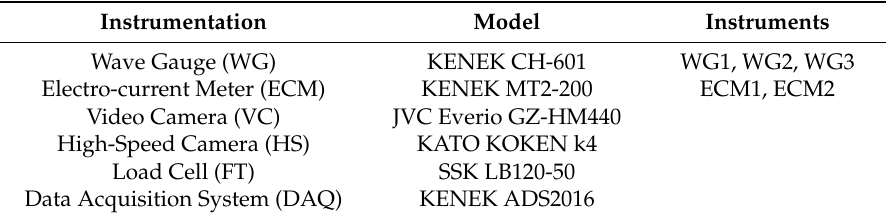
Table 1. Instrumentation used in experimental setup.